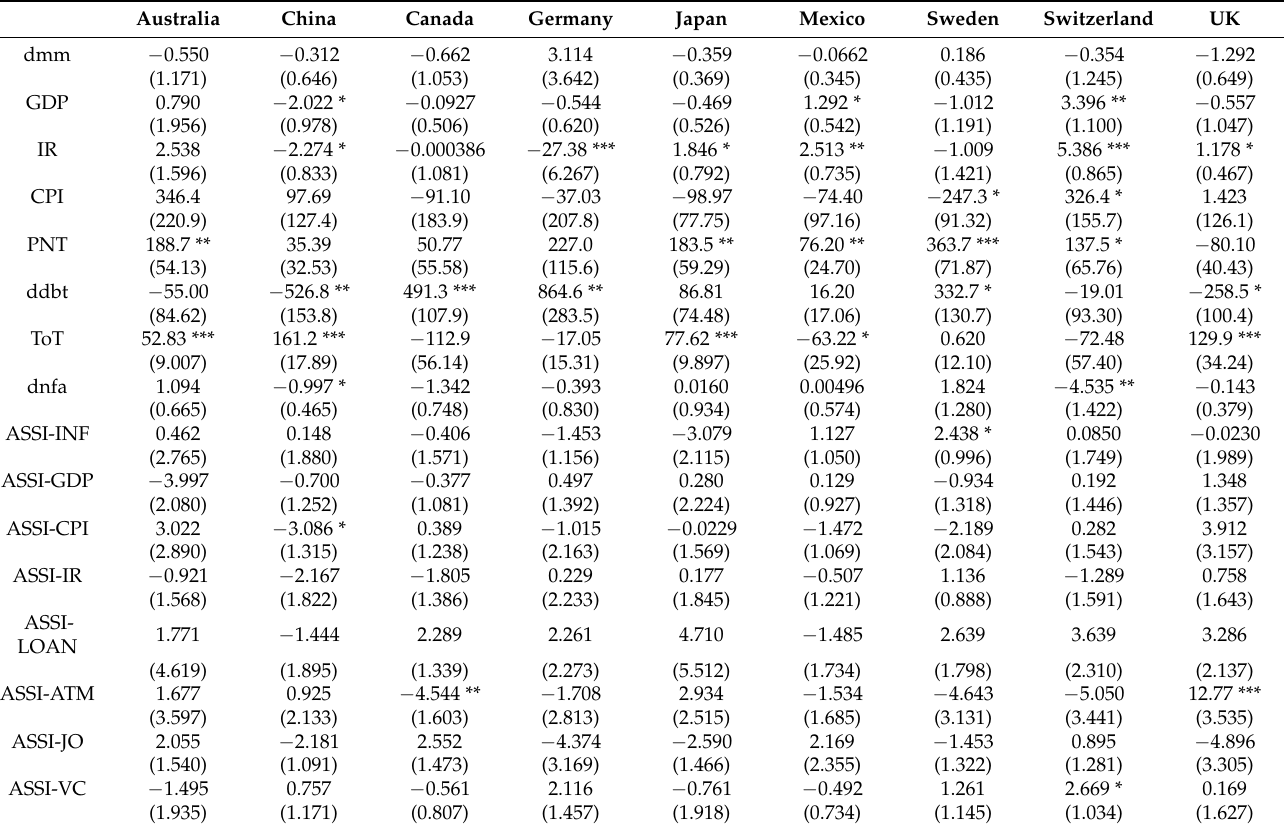
Table A24. Panel Regression AM Model with ASSI for